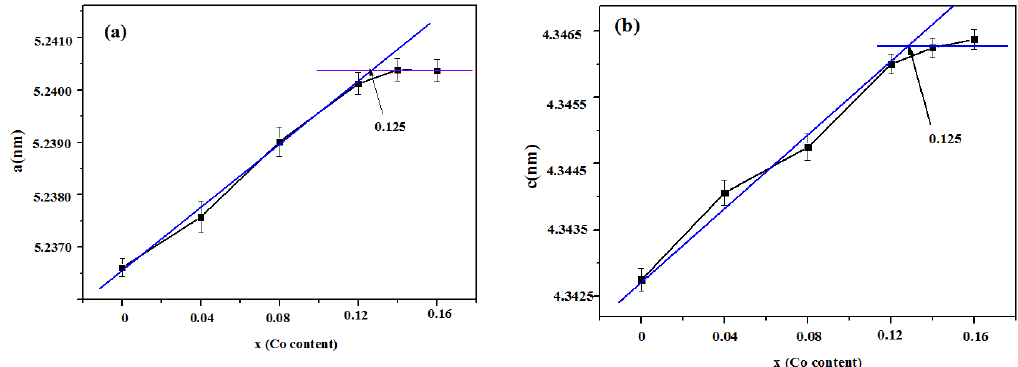
Figure 9. Variation of ( a ) the lattice parameter a and ( b ) lattice parameter c of Ni 1 − x Co x In on Co content.